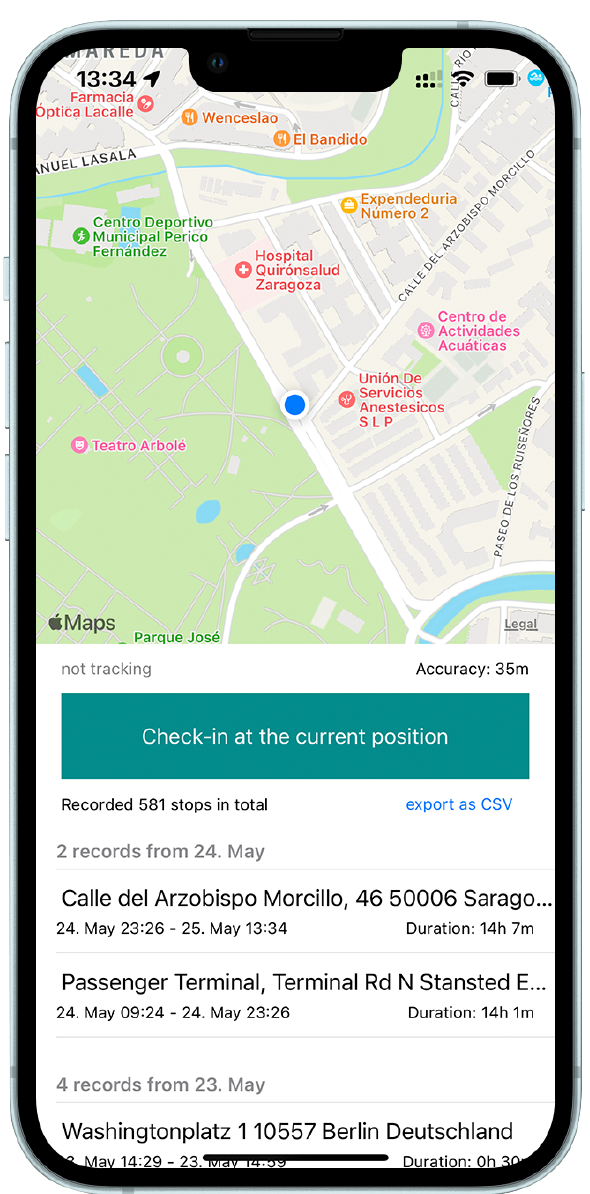
Figure 3. Screenshot of the annotation companion app, which recorded the diary entries. On arrival at a location, the user checked in to their current position to track the start timestamp. Right before they left a dwelling spot, they logged that with a second tap to track the end of the interval.